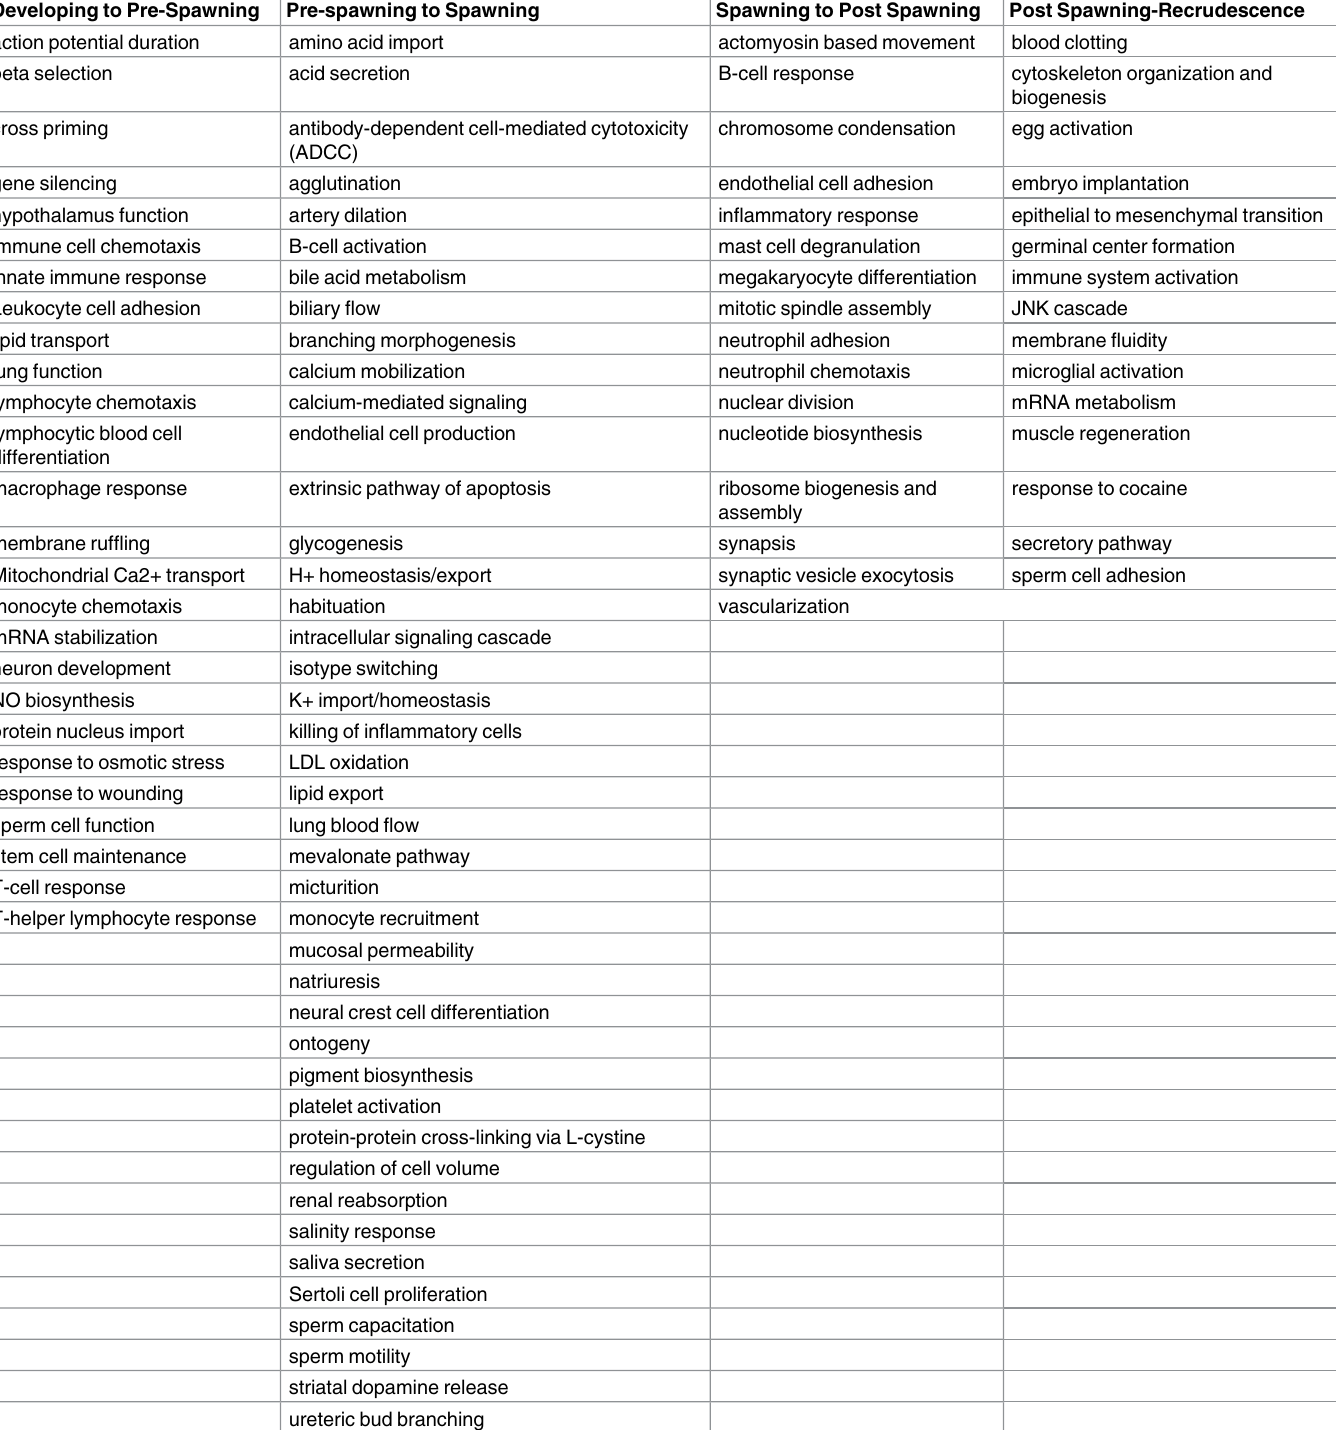
Table 3. Pathways identified as differentially expressedrelative to the stage before during RBD testis development. Developing to Pre-Spawning